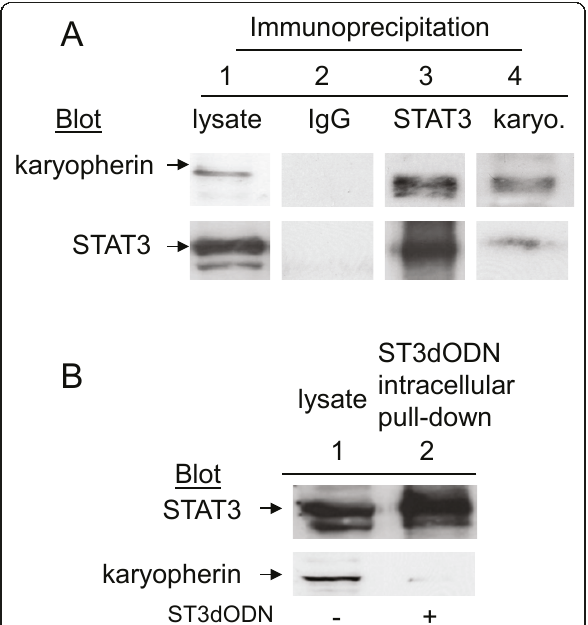
Figure 8 Interaction of STAT3 with the importin/karyopherin complex is impaired by STAT3-decoy ODN . A : Co- immunoprecipitation of STAT3 with karyopherin a . Cells were lysed and immunoprecipitation performed with anti-STAT3 (1:100) (3) or with anti-karyopherin a (1:40) (4) antibodies. A control experiment was performed with non-relevant immunoglobulin (IgG, 1:50) (2). After separation on gel and transfer, the membrane was probed with anti-karyopherin a (1:400) or anti-STAT3 antibody (1:1000). A control cell lysate was loaded on the gels (1). B : Intra-cellular pull- down assays with the biotinylated STAT3-decoy ODN. Cells were - transfected with biotinylated STAT3-decoy ODN (6 h) and complexes collected with avidin agarose and analyzed by western blotting. Control SW 480 cell lysate (1), STAT3-decoy ODN Figure 7 The CRM1 inhibitor leptomycin B and the (ST3dODN) pull-down (2). Membranes were probed with antibody phosphatase inhibitor vanadate reverse inhibition of STAT3 to STAT3 and reprobed with antibody to karyopherin a . nuclear translocation by STAT3-decoy ODN . A : Amounts of nuclear STAT3 following treatment of cells with leptomycin (LMB) or vanadate. Cells were either not treated (1) or treated with LMB (10 ng/ml, 3 h) (2), sodium vanadate (100 μ M, 2 h) (3), or both (4); for clarity, only nuclear extracts (N) are shown. B : Effect on STAT3 nuclear localization of cells ’ simultaneous treatment with STAT3- decoy ODN, LMB, and vanadate. Cells were either not transfected (1) or transfected with STAT3-decoy ODN alone (2 μ g/ml) (4), STAT3-decoy ODN (2 μ g/ml) and vanadate (100 μ M) (2), or STAT3- decoy ODN (2 μ g/ml) and LMB (10 ng/ml, 3 h) (3). Only nuclear extracts are shown (N). C : Quantitative analysis of nuclear STAT3 from several experiments identical to those shown in A and B. STAT3 amounts quantified by scanning are expressed relative to control (in %). Conditions were: STAT3-decoy ODN (ST3dODN) and vanadate (VO 4 ), STAT3-decoy ODN and LMB, STAT3-decoy ODN alone, vanadate, LMB, vanadate and LMB. Data are from at least three separate